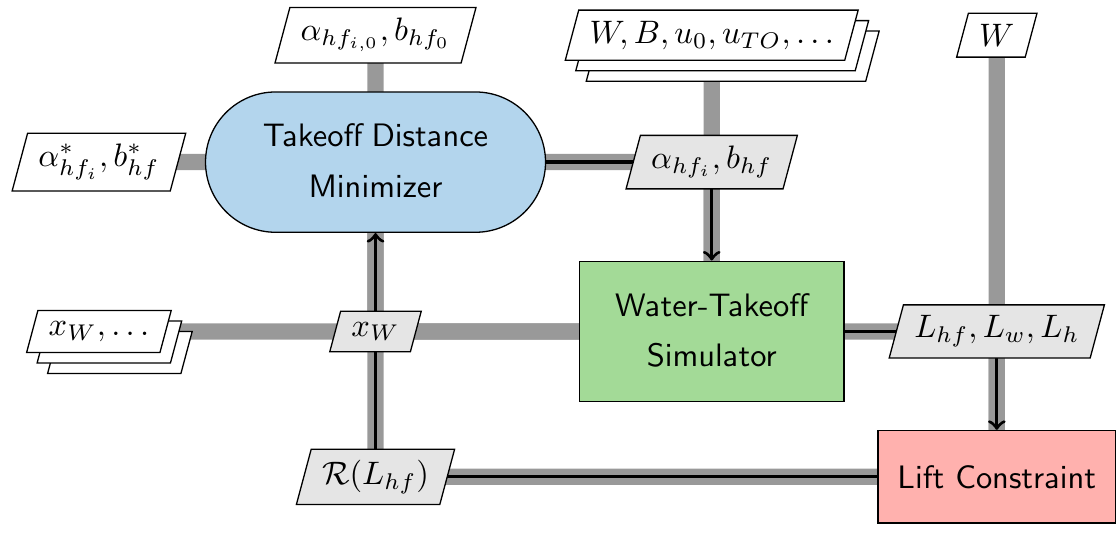
Figure 2. XDSM diagram for the hydrofoil span and incidence angle